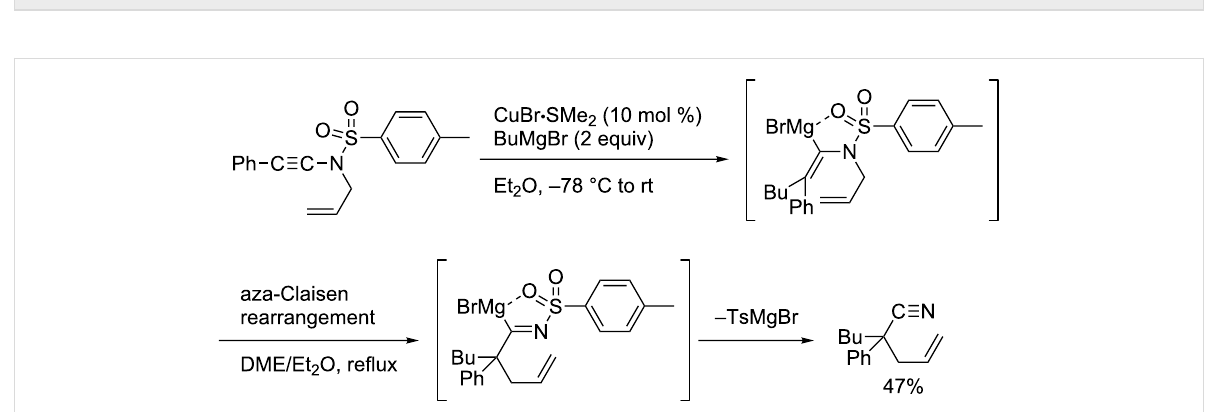
Scheme 15: Synthesis of 4-pentenenitriles through carbometalation followed by aza-Claisen rearrangement.